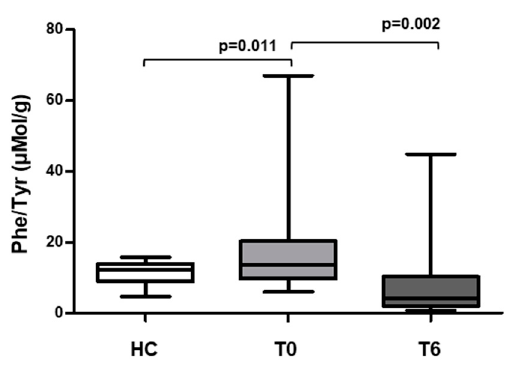
Figure 2. Phenylalanine/tyrosine ratio (Phe/Tyr) in HC and HIV+ subjects measured before T0 and after T6 supplementation with oral probiotics. The line indicates median population value. Data were analyzed using the Mann–Whitney test for unpaired samples and Wilcoxon test for paired samples.